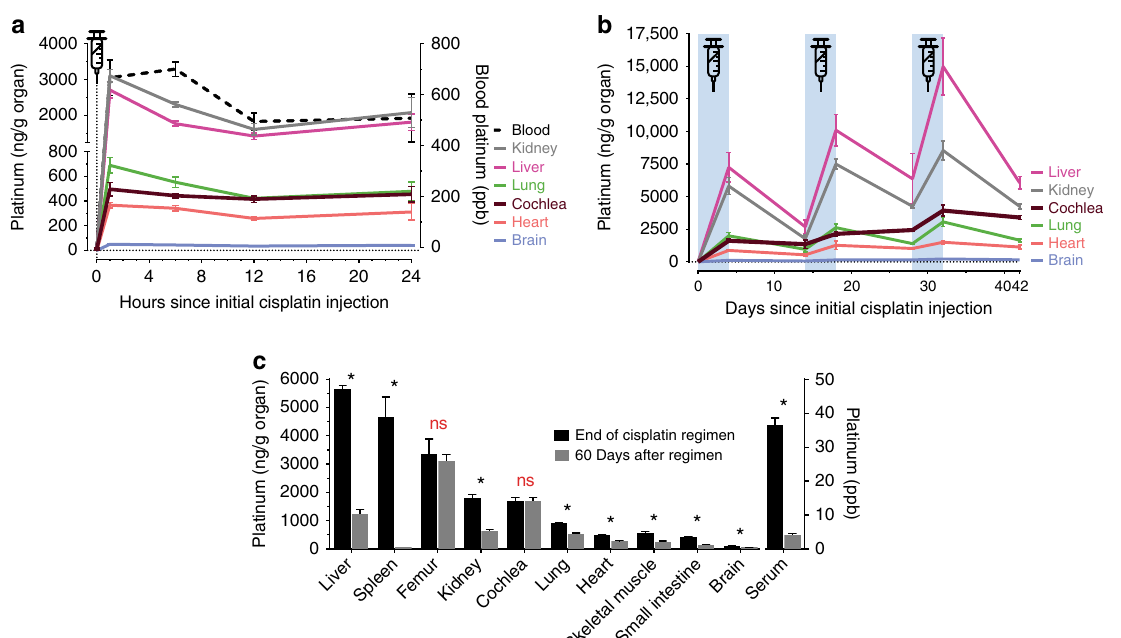
Fig. 2 Cisplatin is readily cleared from most organs but is retained in the cochlea. a ICP-MS measured platinum concentrations in whole mouse organs isolated throughout the fi rst 24 h following a single i.p. injection of cisplatin. 0-h data points represent mice prior to injection of cisplatin. Concentrations are normalized to organ mass (ng Pt per g of organ, left y -axis) or expressed as parts per billion (ppb, right y -axis) for whole blood. Platinum levels peak in most organs 1 h after injection. Concentrations vary signi fi cantly across organs and are highest in kidney and liver. n = 3 – 4 mice per time point. b Concentrations of cisplatin in whole mouse organs throughout the complete 42-day cisplatin regimen. The three, 4-day long cycles of once-daily i.p. cisplatin are indicated by blue shading. In most organs, platinum levels increase following injection and then decline during the recovery period. In contrast, platinum progressively accumulates in cochlea with no apparent elimination. n = 3 – 4 mice at each time point for all organs. c Concentrations of platinum in whole mouse organs at the end of the cisplatin regimen and following a subsequent 60-day recovery. During this recovery period, platinum was signi fi cantly eliminated from all organs except the cochlea and femur. n = 3 – 4 mice in each group. Multiple two-tailed t- tests with correction for multiple comparisons by the Holm – Š idák method were used to determine signi fi cance. Data are expressed as mean ± s.e.m. ns not signi fi cant, * P <